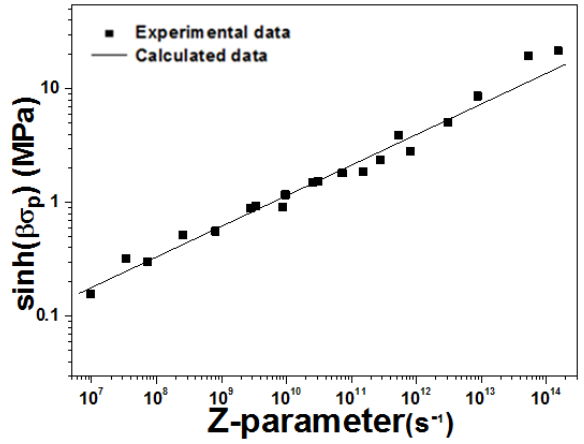
Figure 9. Comparison between the experimental and calculated data.